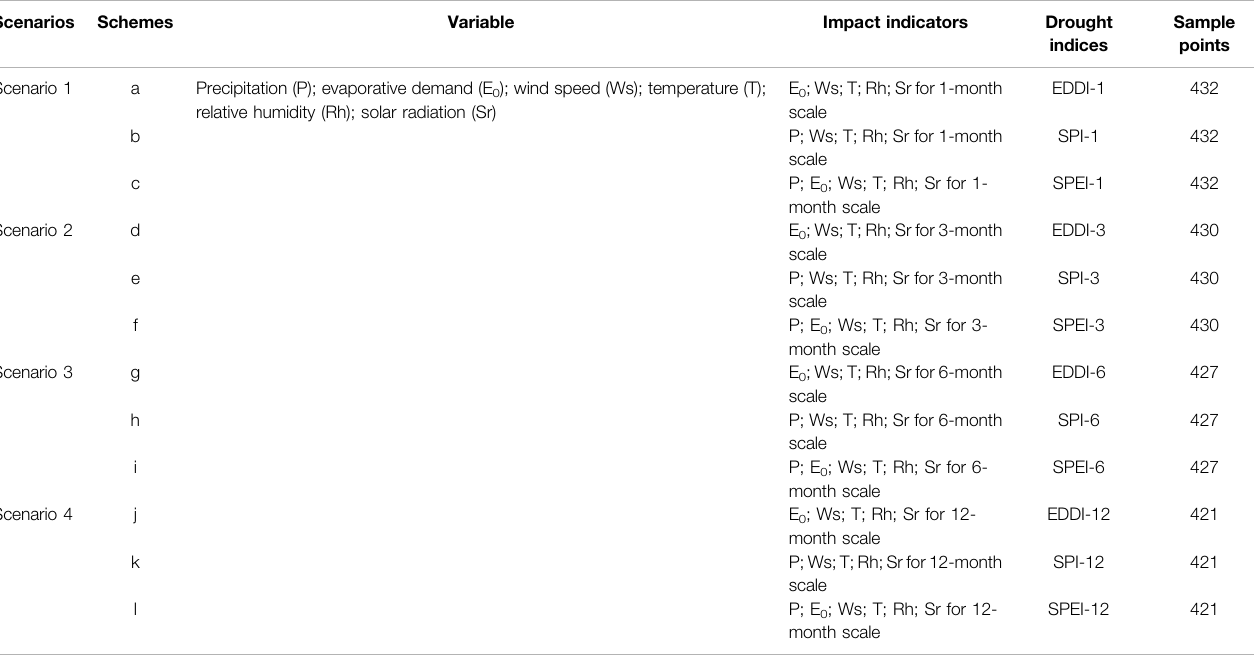
TABLE 2 | Information of the four scenarios for the contribution of drought change.